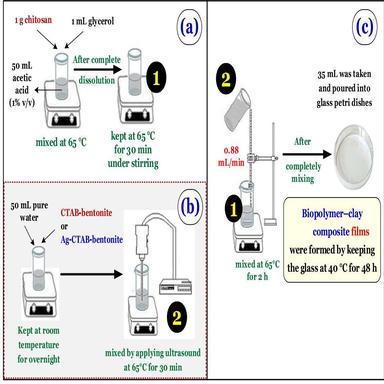
Experimental procurer for preparing (a) Solution 1, (b) Solution 2, and (c) biopolymer–clay composite films.